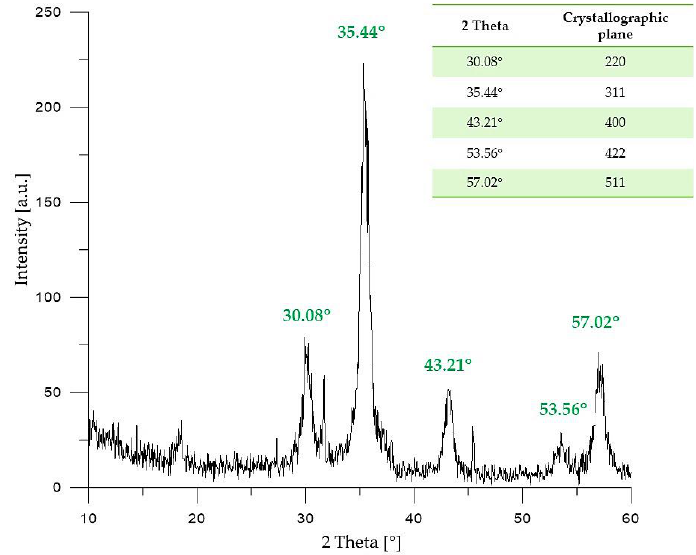
Figure 1. XRD (X-Ray Diffraction) pattern of Fe 3 O 4 particles. On the X-ray diffractogram of Fe 3 O 4 particles presented above, five diffraction peaks with 2 θ values of 30.08 ◦ ; 35.44 ◦ ; 43.21 ◦ ; 53.56 ◦ and 57.02 ◦ may be observed. The mentioned peaks are characteristic for the following crystallographic planes of iron (II, III) oxide with a cubic structure: 220, 311, 400, 422, and 511, respectively. The diffraction peaks indicated on the XRD diffractogram presented in Figure 1 correspond to the diffraction peaks of pure Fe 3 O 4 presented in the reference database (JCPDS Card: 19–629) [36,37], and are very similar to the XRD patterns of Fe 3 O 4 nanoparticles presented in other publications [38]. In Figure 2 below, a FT-IR spectrum of the analyzed Fe 3 O 4 particles is shown.